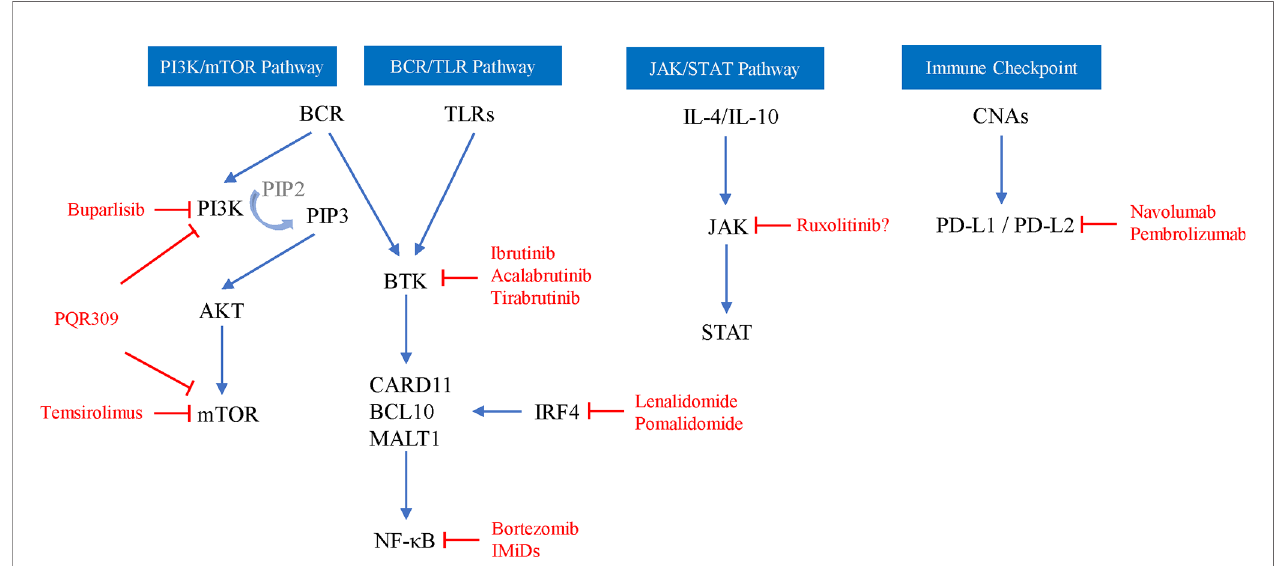
FIGURE 2 | Schematic depiction of key mechanisms of PCNSL and related targeted agents (red words). PIP2, 3,4-diphosphate phosphatidylinositol; PIP3, 3,4,5- triphosphate phosphatidylinositol; AKT, serine/threonine kinase; CARD11, caspase recruitment domain-containing protein 11; BCL10, B-cell lymphoma 10 protein; MALT1, mucosa-associated lymphoid tissue lymphoma translocation protein 1; IRF4, interferon regulatory factor 4; CNAs, copy number